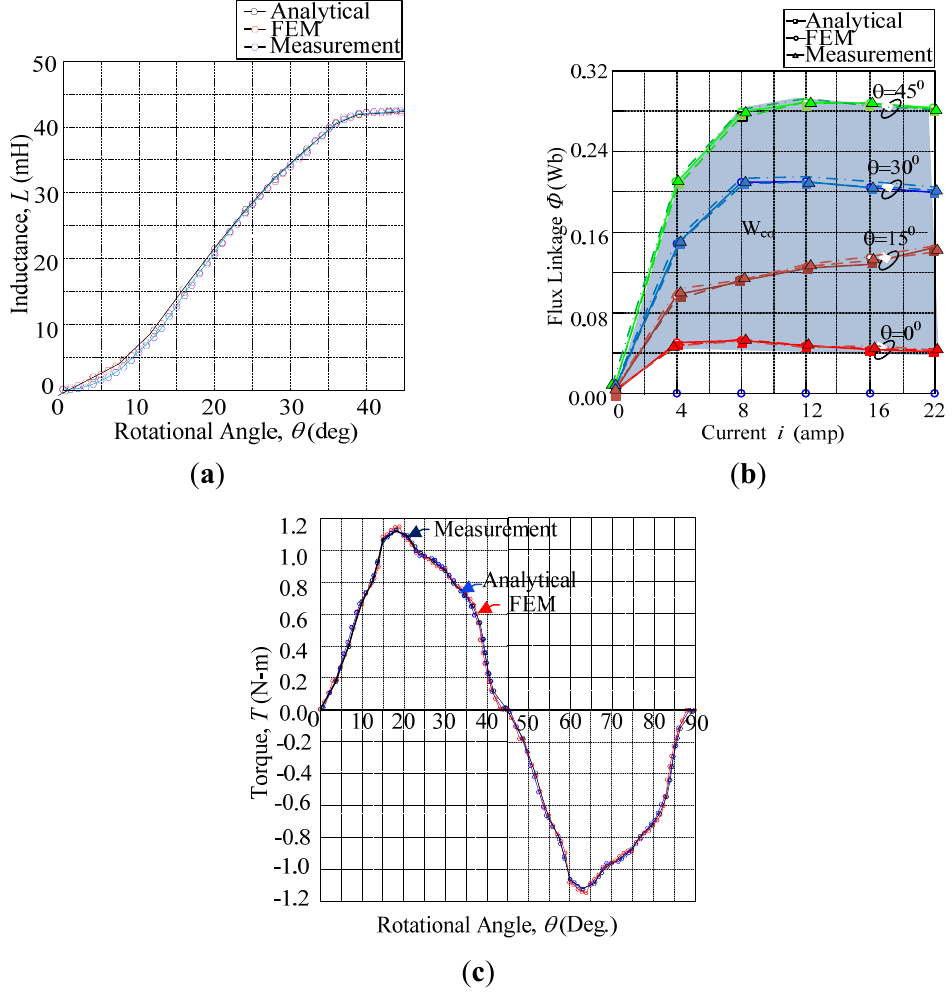
Figure 10. Inductance profile comparison of analytical method evaluations: ( a ) inductance characteristics; ( b ) flux linkage characteristics; ( c ) torque